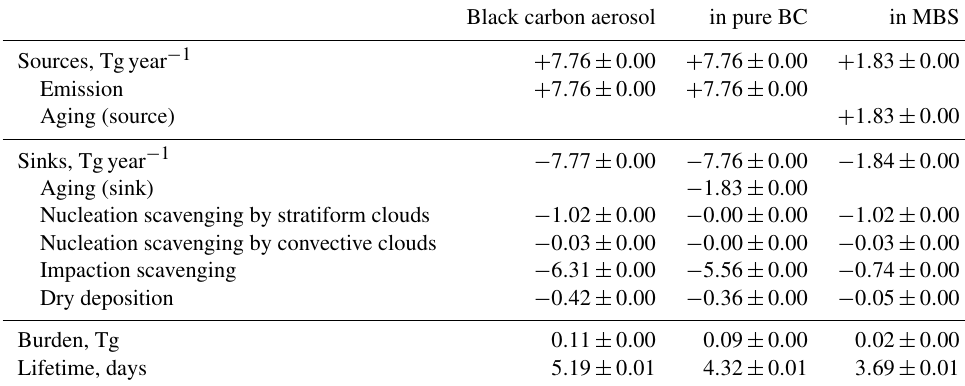
Table 3. Global mass budgets and lifetimes of black carbon aerosol for the year-2000 MARC simulation, showing values for total black carbon aerosol and black carbon aerosol in each mode. The processes acting as sources and sinks are summarised in Fig. 1c. Aging transfers black carbon between modes, but does not directly influence the total black carbon aerosol mass. Corresponding results for the year-1850 MARC simulation are shown in Table S3.